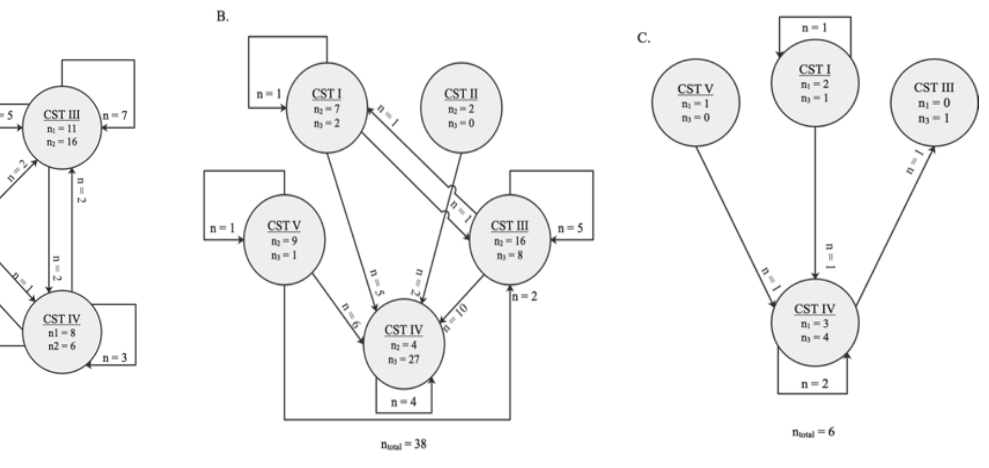
Figure 5. Schematic representation of the switch between community state types (CSTs) between two sampling timepoints. The numbers in the circles indicate how many vaginal samples were clustered in a certain CST by the time collection (during pregnancy). Arrows represent the direction of the switch. The numbers by the arrows represent the number of vaginal microbiota tested belonging to the same women who switched to a given CST at a later timepoint. ( A ) Thirty-eight women were clustered with a specific CST at timepoint <20 weeks GA and ≥ 20 weeks GA during pregnancy, of which 18 CST changed type during pregnancy. ( B ) Among the paired vaginal swabs tested at ≥ 20 weeks GA and post-delivery, 27 of the 38 CST changed. ( C ) The CST of three of the vaginal swabs from the same six women tested at <20 weeks GA and post-delivery changed.